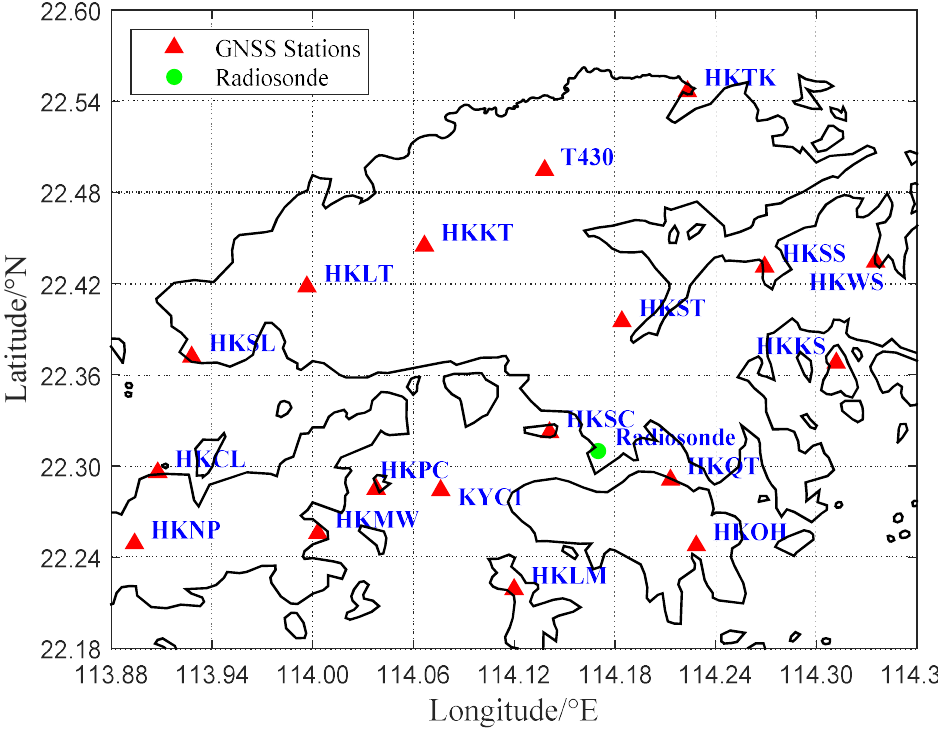
Figure 6. Horizontal grid scheme in the study area. The selected study area was divided into a 7 × 8 grid, 7 in the latitudinal and 8 in the longitudinal direction.